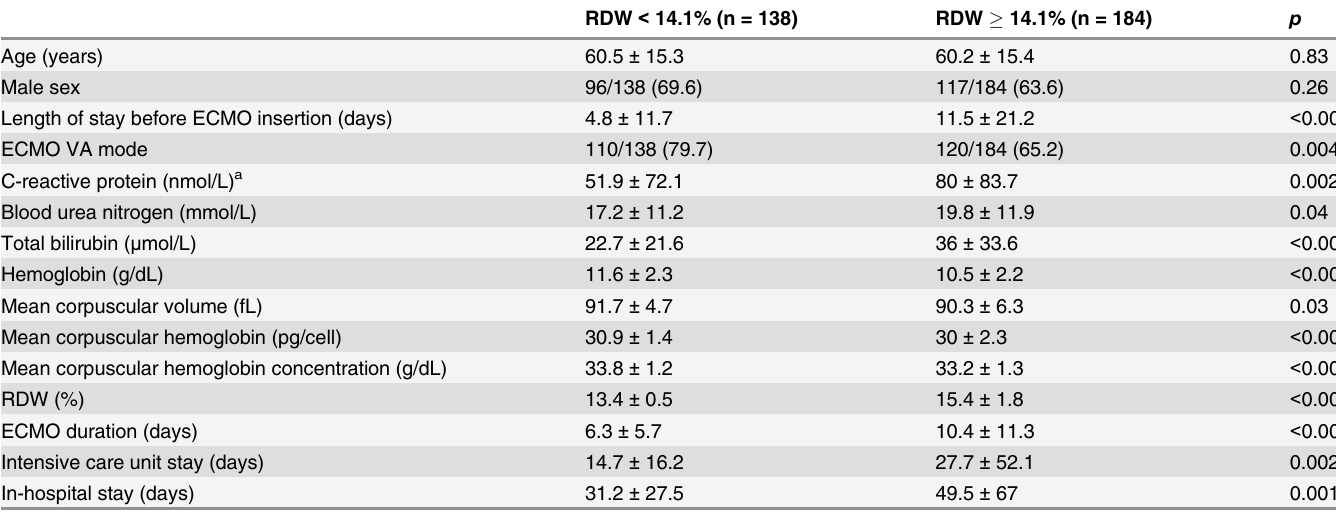
Table 7. Patient characteristics according to the status of